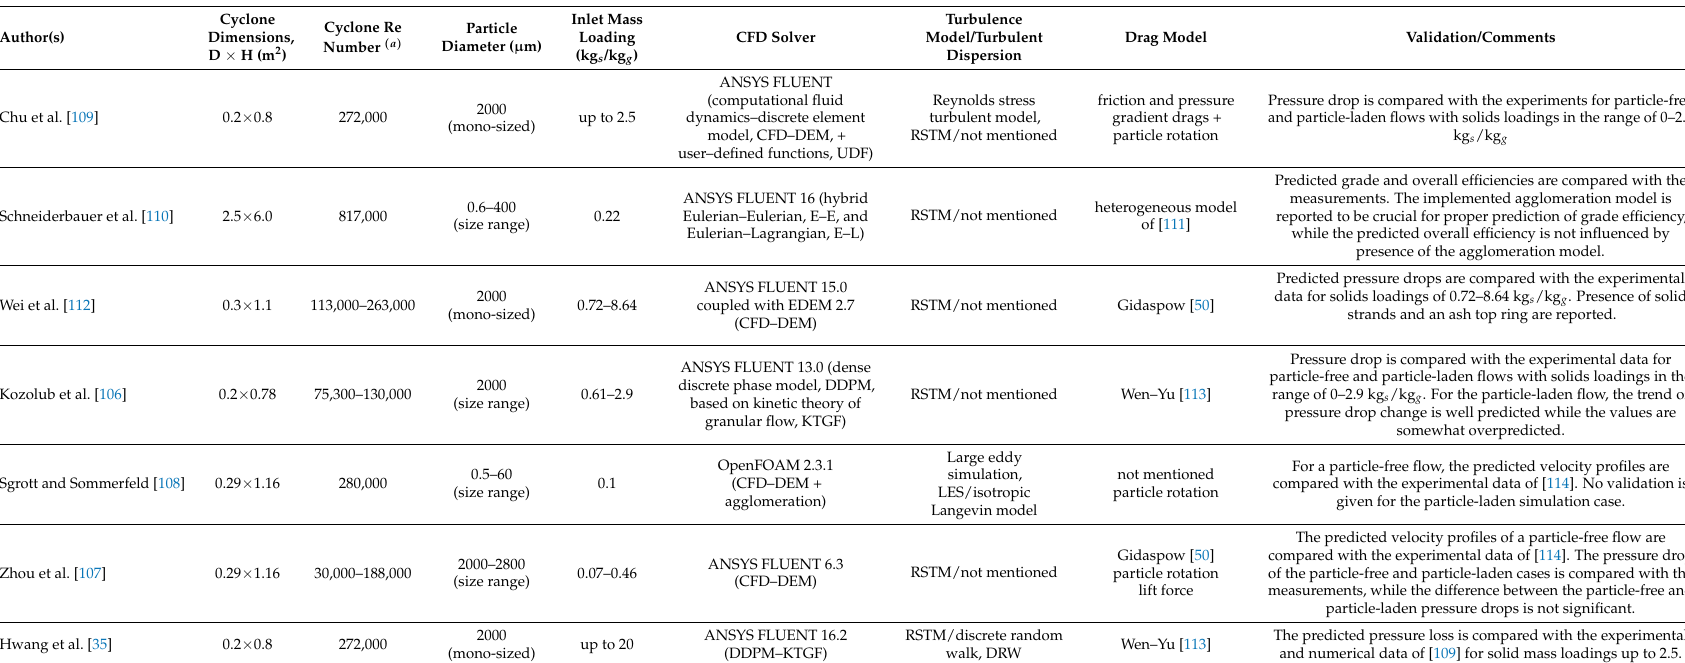
Table 2. Details of the selected CFD studies of gas–solid flow in cyclones operating at ambient temperature with the four-way coupling method, in chronological